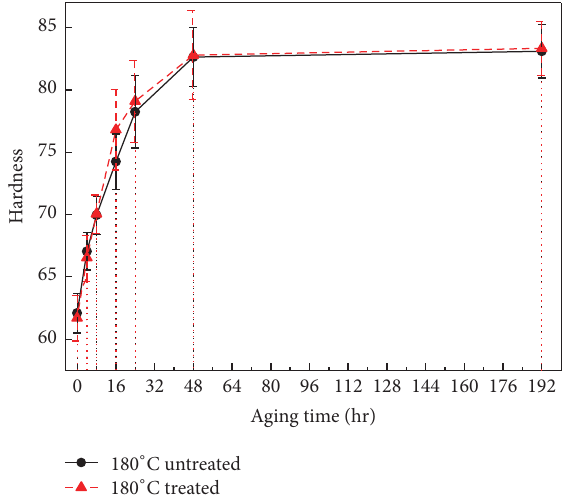
Figure 5: Hardness of the polyketone/NR composite after thermal aging at 180 ∘ C.